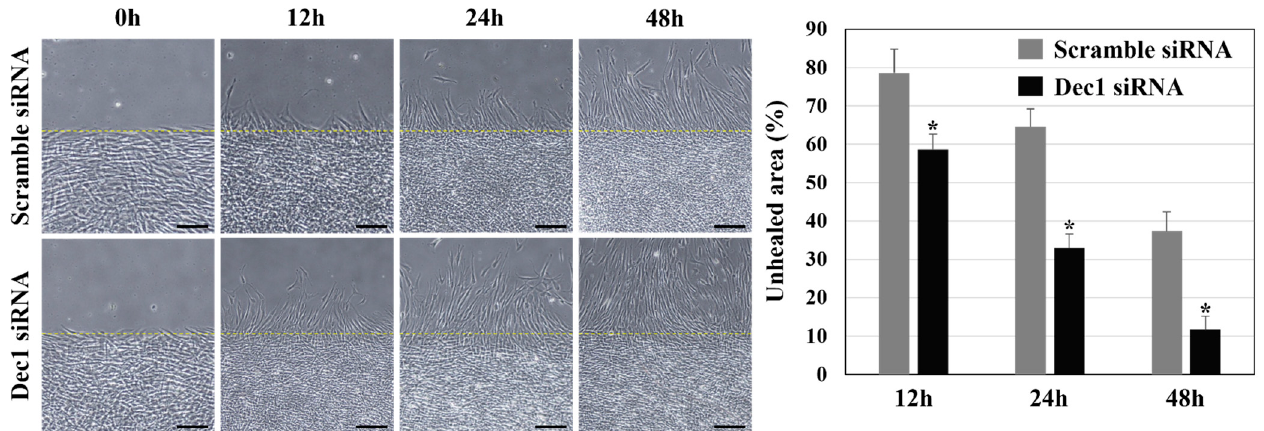
Figure 13. Dec1 deficiency promotes the migration of hPDL fibroblasts under hypoxic conditions. The cell migration ability of hPDL fibroblasts is induced by Dec1 knockdown at all time points, compared with the control group. Scale bars = 20 μ m. The data shown represent the means ± SD of experiments carried out in triplicate; * p < 0.05.